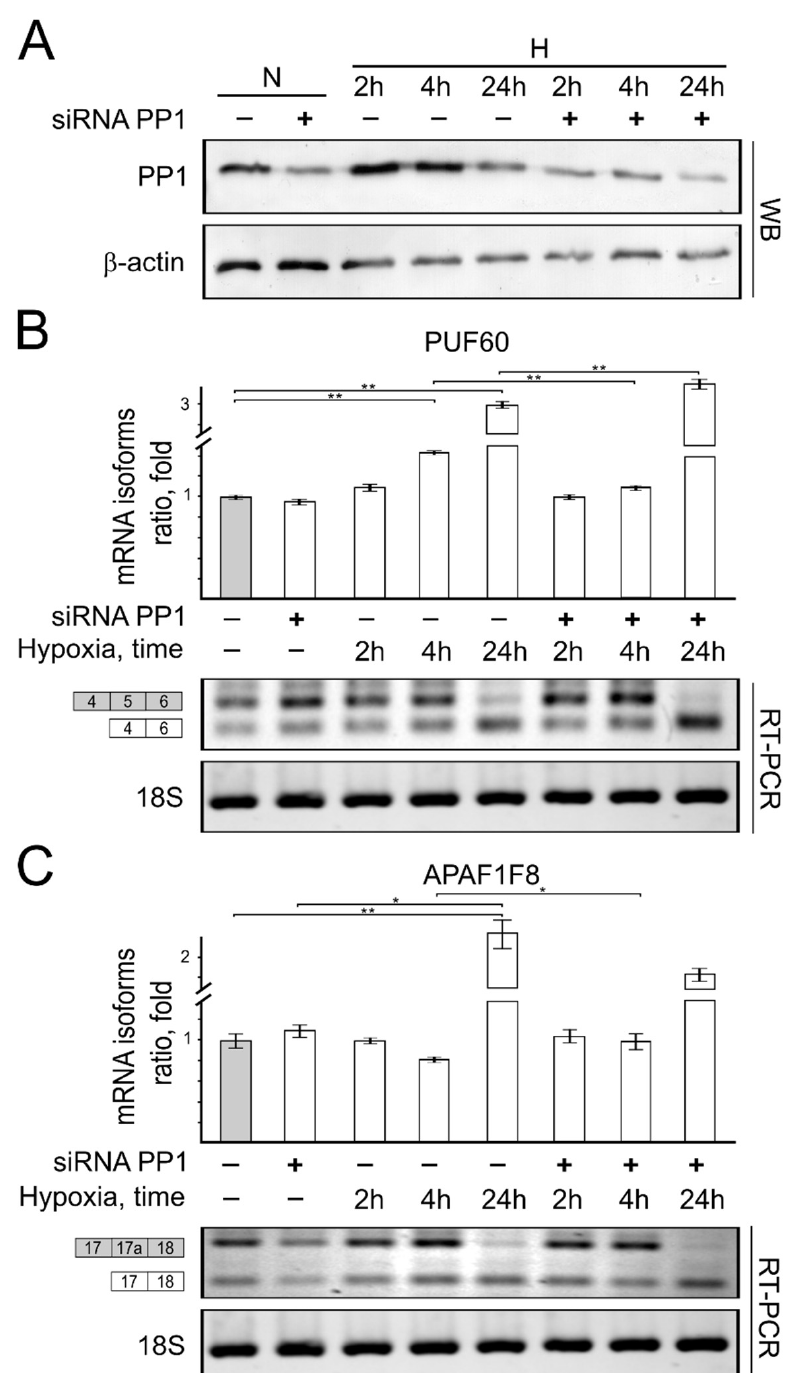
Figure 7. The role of PP1 protein expression for PUF60 and APAF1F8 splicing in normoxic and hypoxic HCT116 cells. Western blot showing PP1 ( A ) protein expression levels in normoxic and hypoxic cells. Reverse transcription PCR (RT-PCR) results showing PUF60 and APAF1F8 gene alternative mRNA isoform expression ratio in reduced PP1 ( B , C ) protein levels expressing normoxic and hypoxic HCT116 cells. Bar plot represents the quantification of endogenous protein expression of 3 independent experiments when protein expression in cells grown under normal oxygen conditions is taken as 1. Error bars represent the amount of spread between the extremes of the data, ** p < 0.05; * p < 0.01. N—cells cultivated under normal conditions; H—cells cultivated under hypoxic conditions for indicated time (2 h, 4 h, and 24 h).